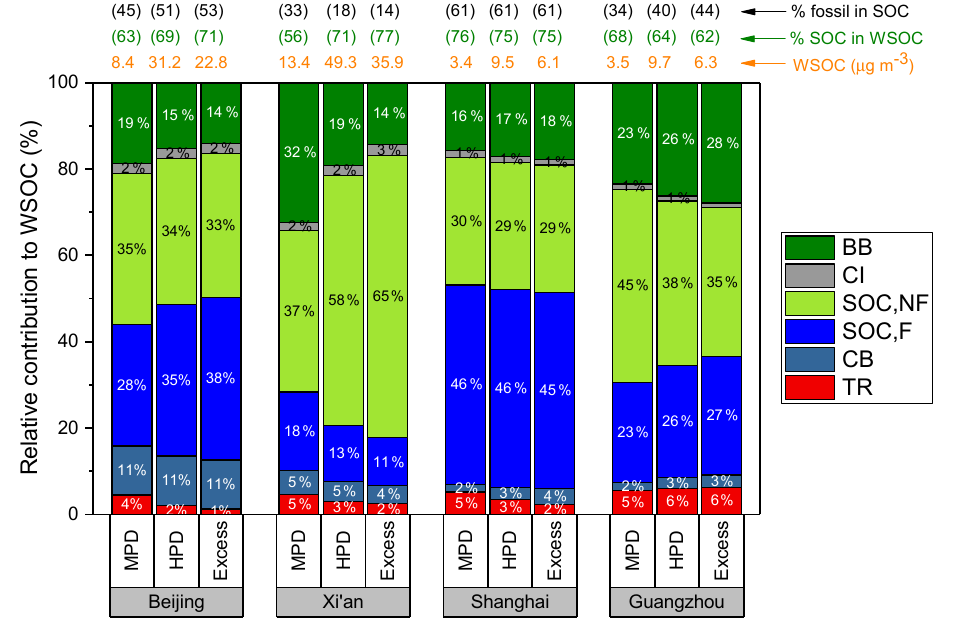
Figure 7. Relative contributions (%) to WSOC from biomass burning, as well as secondary organic carbon (SOC) from fossil and non-fossil sources (WSOC SOC , F and WSOC SOC , NF , respectively) in different cities during moderately polluted days (MPD) and heavily polluted days (HPD), as well as their corresponding excess (Excess = HPD-MPD). The numbers above the bars refer to the average WSOC concentrations and the SOC fractions (%) of